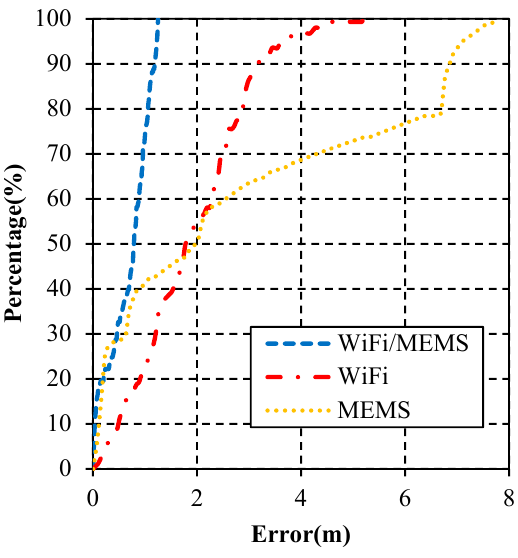
Figure 11. Cumulative error percentages.